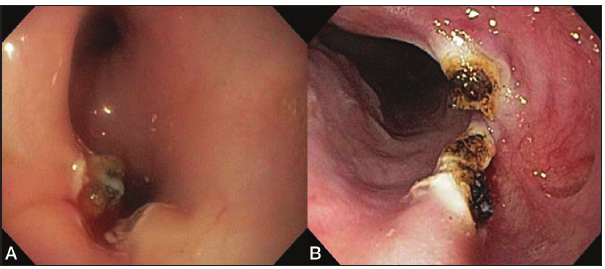
Figure 3) Endoscopic views after resection of mucosal bridge using argon plasma coagulation in patients 1 ( A ) and 2 ( B